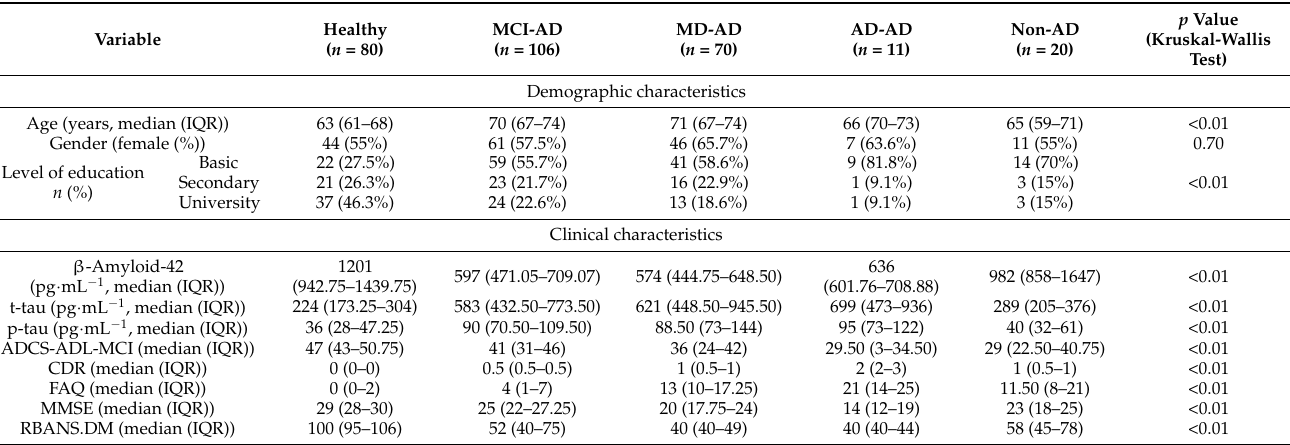
Table 2. Demographic and clinical characteristics of the